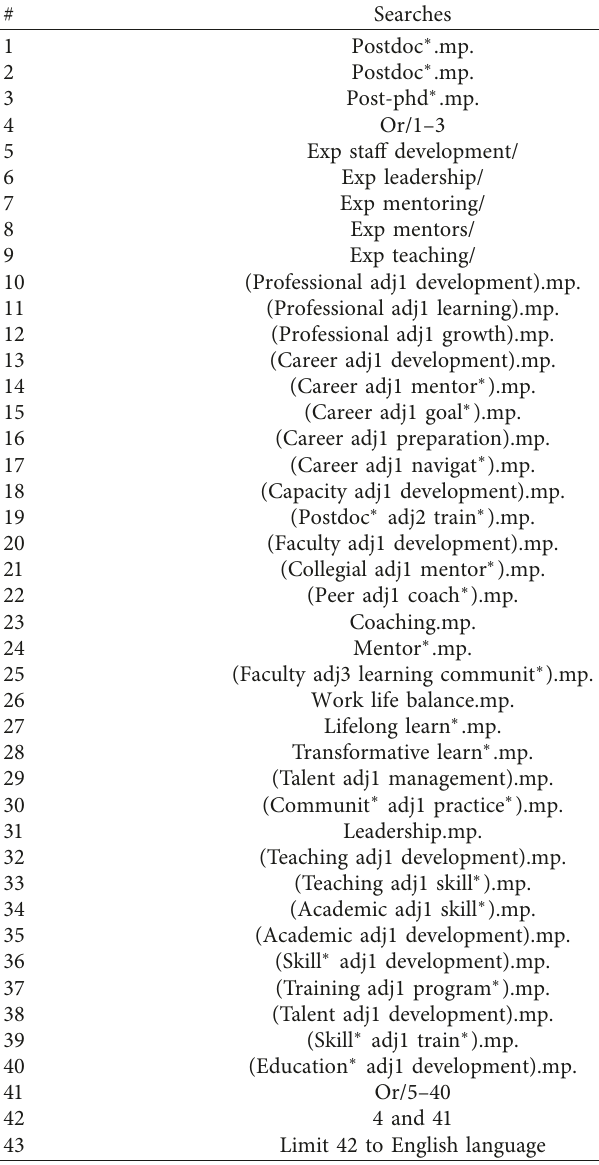
Table 1: Final search strategy for ovid MEDLINE databases: ovid MEDLINE(R) epub ahead of print , in-process and other nonindexed citations , ovid MEDLINE(R) daily , and ovid MEDLINE(R) search